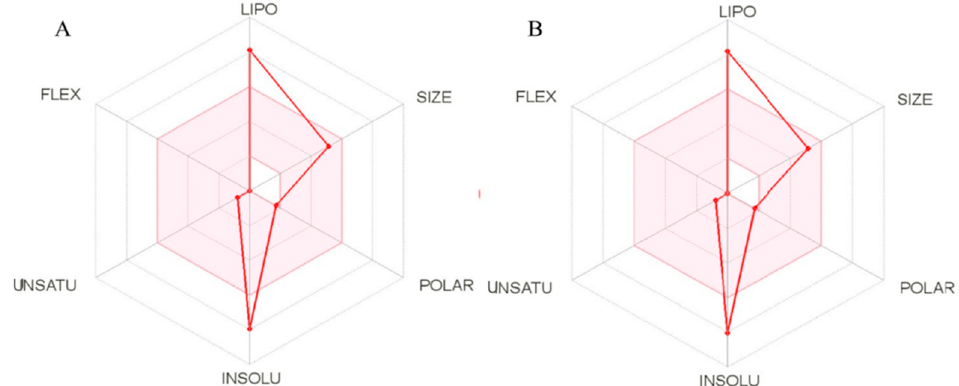
Figure 1. Solubility profiles of α - ( A ) and β - ( B ) amyrenones. Lipo (Lipid affinity), Size (Molecular structure size), Polar (Polarity of the molecule), Insolu (Compound water insolubility), Unsatu (Compound unsaturations), Flex (Structural flexibility).